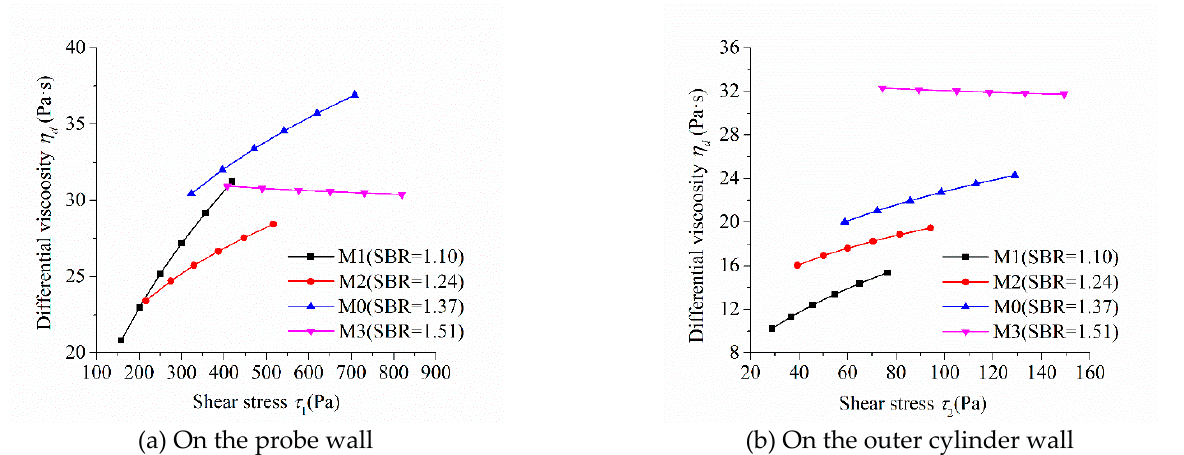
Figure 9. Relationship between thee differential viscosity and shear stress of mortars with different sand:binder ratios.